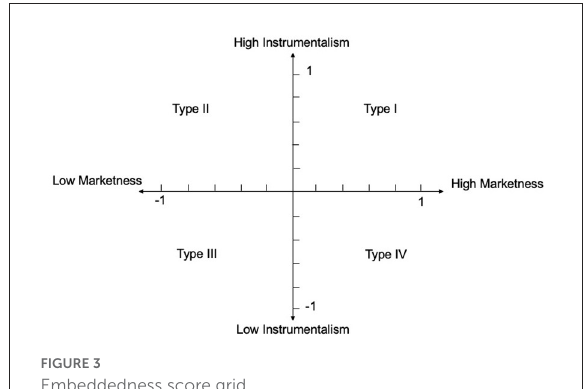
FIGURE3 Embeddedness score